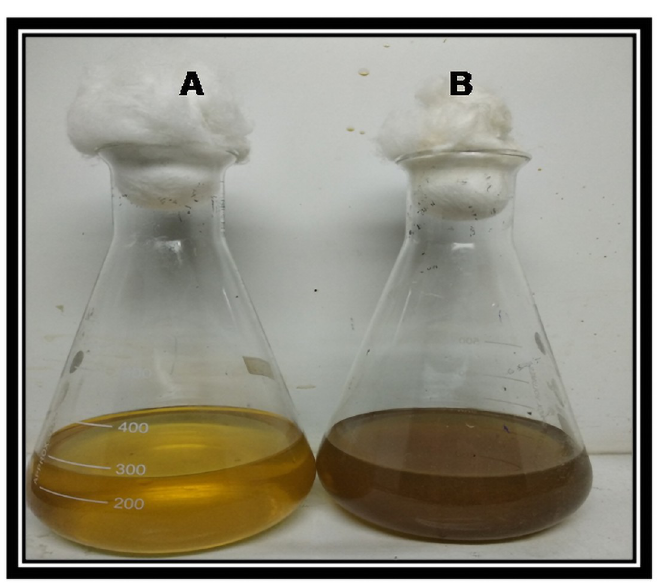
Fig 4. Synthesis of AgNPs by B . marisflavi . A: Zobell marine broth (control) + 1mM Silver nitrate (no color change); B: Culture supernatant of B . marisflavi + 1mM Silver nitrate (visible color change from yellow to